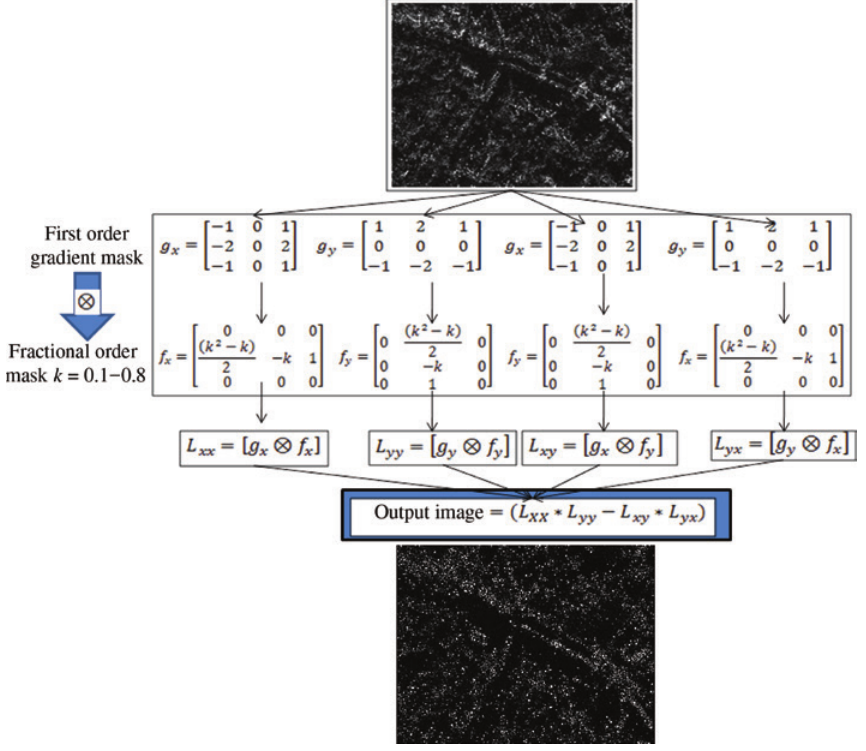
Figure 3: Cornerness Image for ( k =